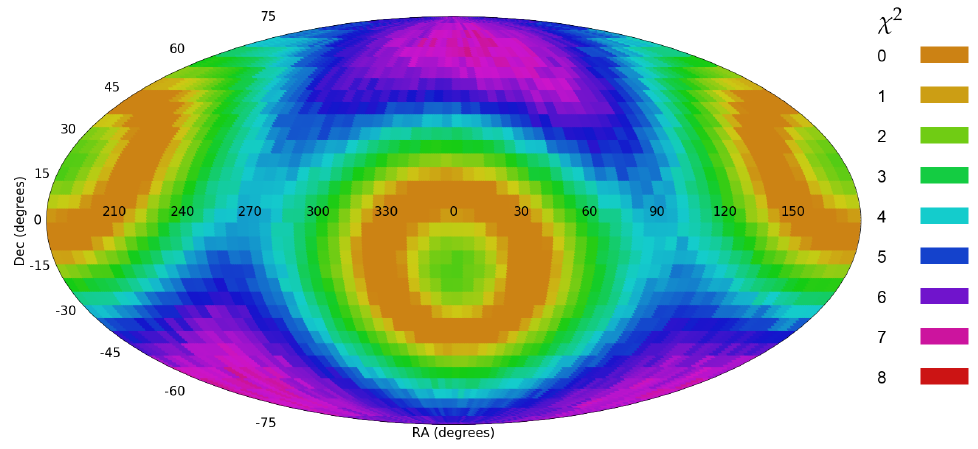
Figure 16. The χ 2 probability of a quadrupole axis in spin directions when 2% of the counterclockwise galaxies are assigned with clockwise spin direction.